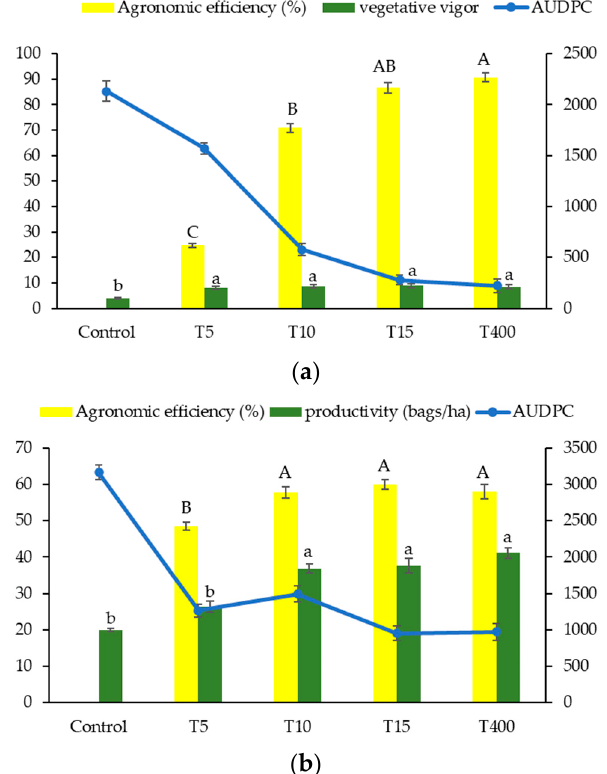
Figure 10. Agronomic efficiency, yield, vegetative vigor, and area under the disease progress curve (AUDPC) for leaf rust ( a ) and cercosporiosis ( b ) in the treatments tested. Bars with the same uppercase letter comparing agronomic efficiency, or lowercase letter comparing yield and vegetative vigor, are not different from each other by Tukey’s test at 5% significance.